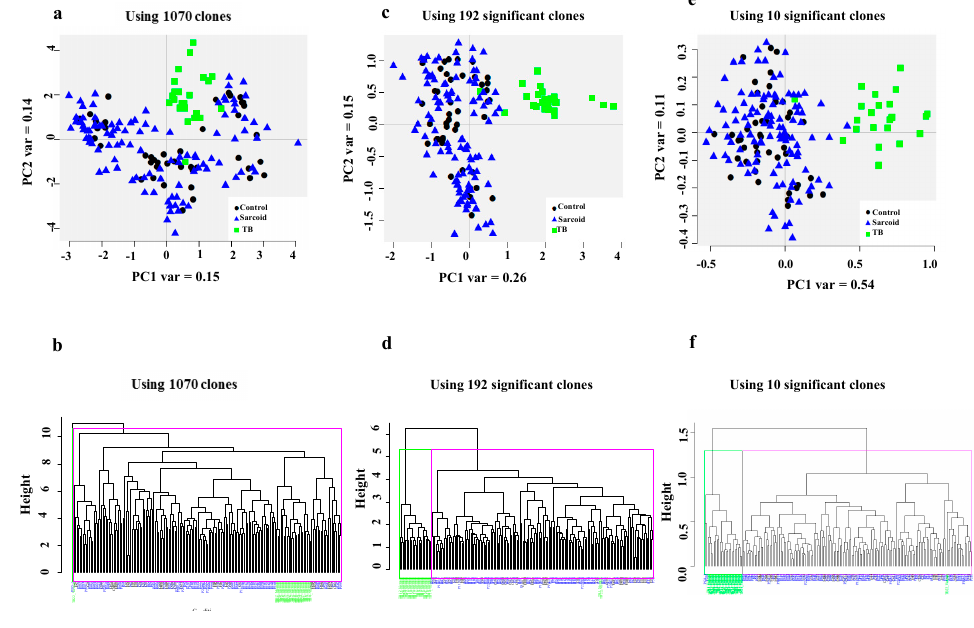
Figure 1. PCA and Hierarchal clustering. ( a ) PCA score plots along PC1 and PC2 generated with 1070 clones of three groups: (1) healthy control samples (black circles); (2) TB samples (green squares) and; (3) Sarcoidosis samples (blue triangle). Biomarker clusters along the PCA1 explain a variance of only 0.15, while the variance along PC2 was about 0.14. ( b ) The hierarchal clustering was applied on the healthy controls (black labels), TB patients (green labels) and sarcoidosis (blue labels) with 1070 clones. ( c ) PCA score plots along the PC1 and 2 results when applied on 192 TB clones. The PC1 explained 0.26 of variance, whereas PC2 explained 0.15 of variance. As shown, the TB samples are well separated from the healthy controls and sarcoidosis samples. ( d ) Hierarchal clustering using only the highly significant 192 TB clones. The blue and black clusters include sarcoidosis and healthy controls, the green cluster includes all the TB samples except one. ( e ) PCA score plots along PC1 and 2 generated with top 10 highly significant clones. The PC1 explained 0.54 of variance, whereas PC2 explained 0.11 of variance. ( f ) Hierarchal clustering using 10 top significant TB clones. This figure demonstrates better clustering with 192 TB clones and the highly significant 10 TB clones (panels c, d, e, and f) when compared the clustering using all clones (panels a and